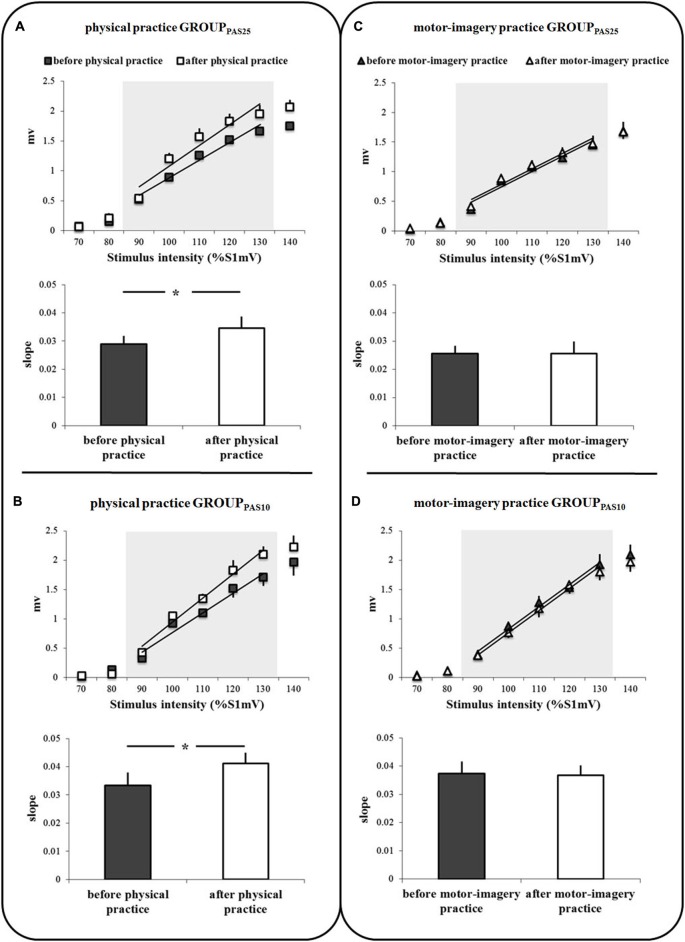
IO curves measured in the abductor pollicis brevis (APB) muscle, before and after physical practice (A,B) and before and after motor-imagery practice (C,D). Data of both GROUPPAS25
(A,C) and GROUPPAS10
(B,D) are shown. Trend lines indicate the linear fit applied to the range from 90% to 130% S1mV above RMT as indicated by the shaded area. The slopes of the IO curves are depicted in the inferior part of each panel (A,D). The slope was estimated from the linear part of the IO curve between 90% and 130% S1mV above RMT. Vertical bars indicate SE. Asterisks indicate the level of significance (* p < 0.05).